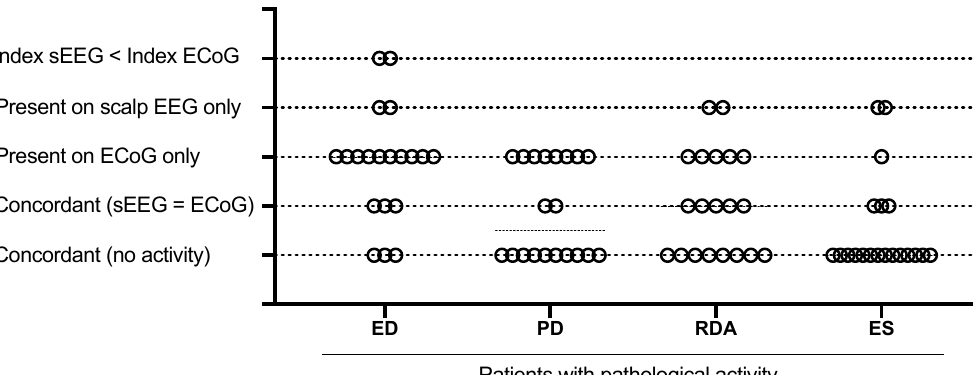
Figure 3. Distinctions in the pathological activities detected in scalp EEGs and ECoGs. The analysis of discordance between scalp EEG (sEEGs) and ECoGs was performed. Each dot denotes a patient with (or without) different pathological activity (left to right: ED, epileptiform discharge; RDA, rhythmic delta activity; PD, periodic discharges; ES, electrographic seizures). Concordance or discordance between sEEG and ECoG is shown on different lines. A discordance was identified if the activity was present either on sEEG or ECoG, or if differences in ED index changes were significant (for ED). The concordance was stated if the activity was presented or absent in both scalp and invasive electrodes. The ECoG was more sensitive with respect to ED and PD, and, in some patient, RDA and ES could be detected only with invasive electrodes, n = 21.